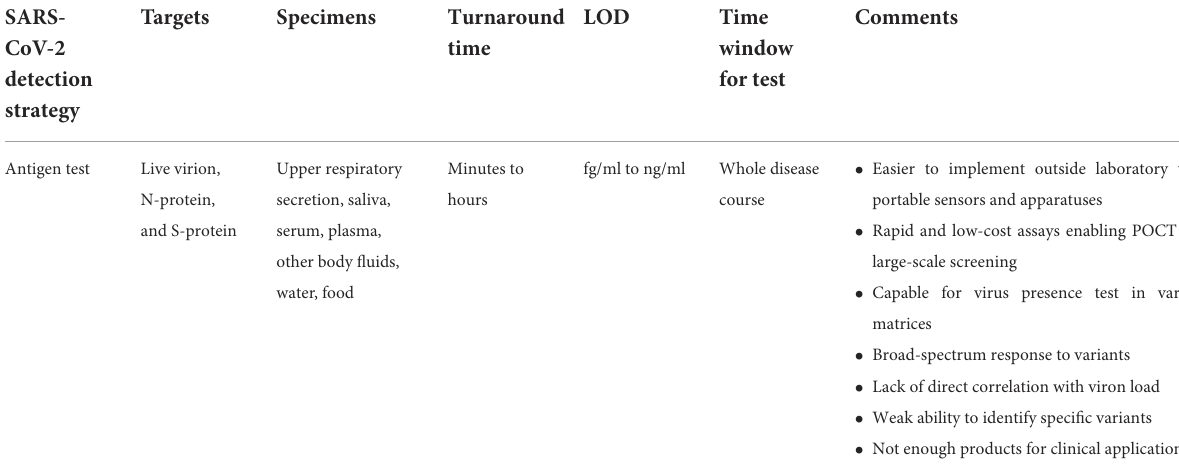
TABLE 1 Features of antigen tests for SARS-CoV-2 detection. SARS- CoV-2 detection